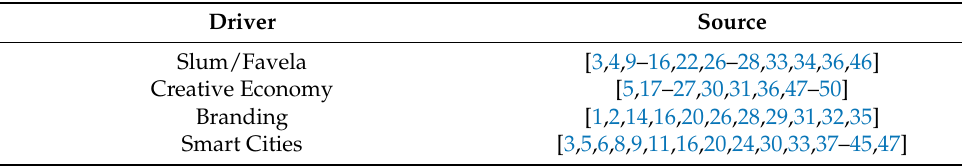
Table 1. Guidelines in the